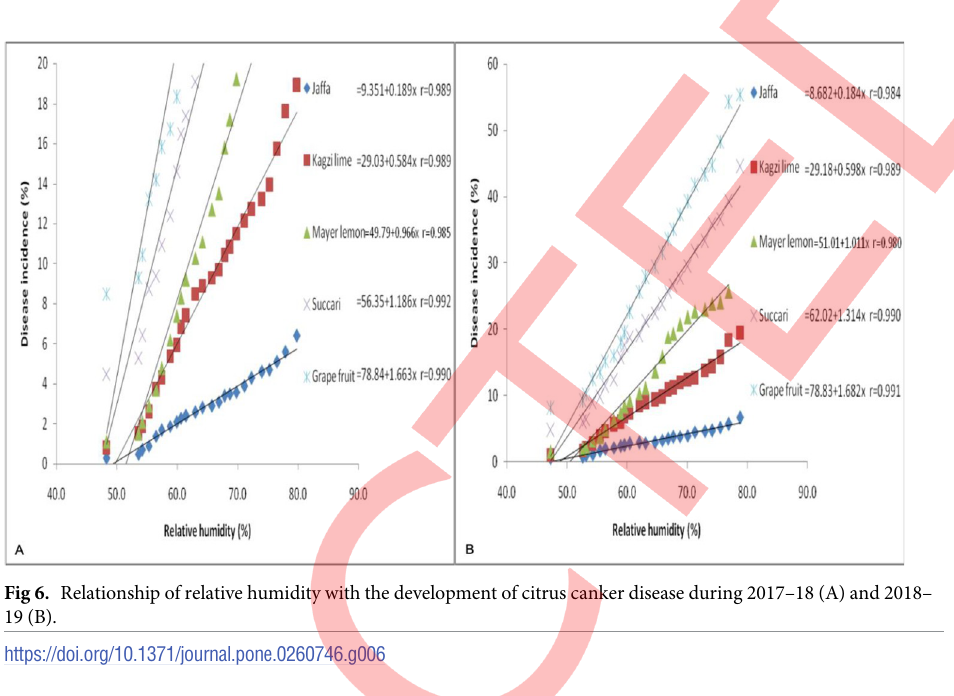
Fig 6. Relationship of relative humidity with the development of citrus canker disease during 2017–18 (A) and 2018– 19 (B).